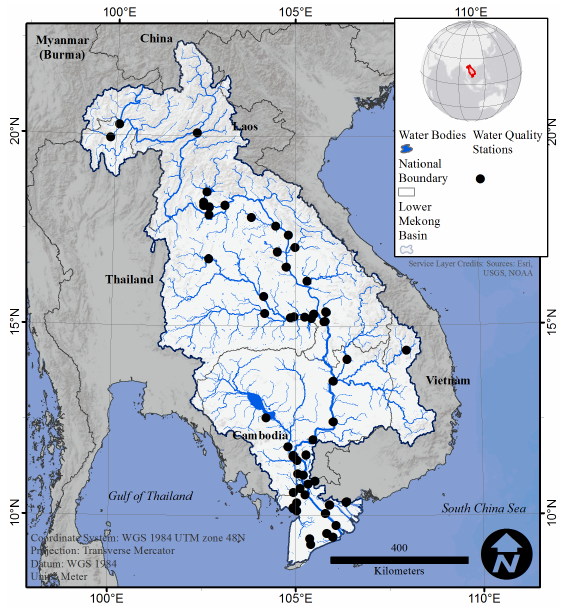
Figure 1. Study area map of the Lower Mekong Basin highlighting geopolitical boundaries, the river systems in the region, and the water quality monitoring stations included in the MRC water quality